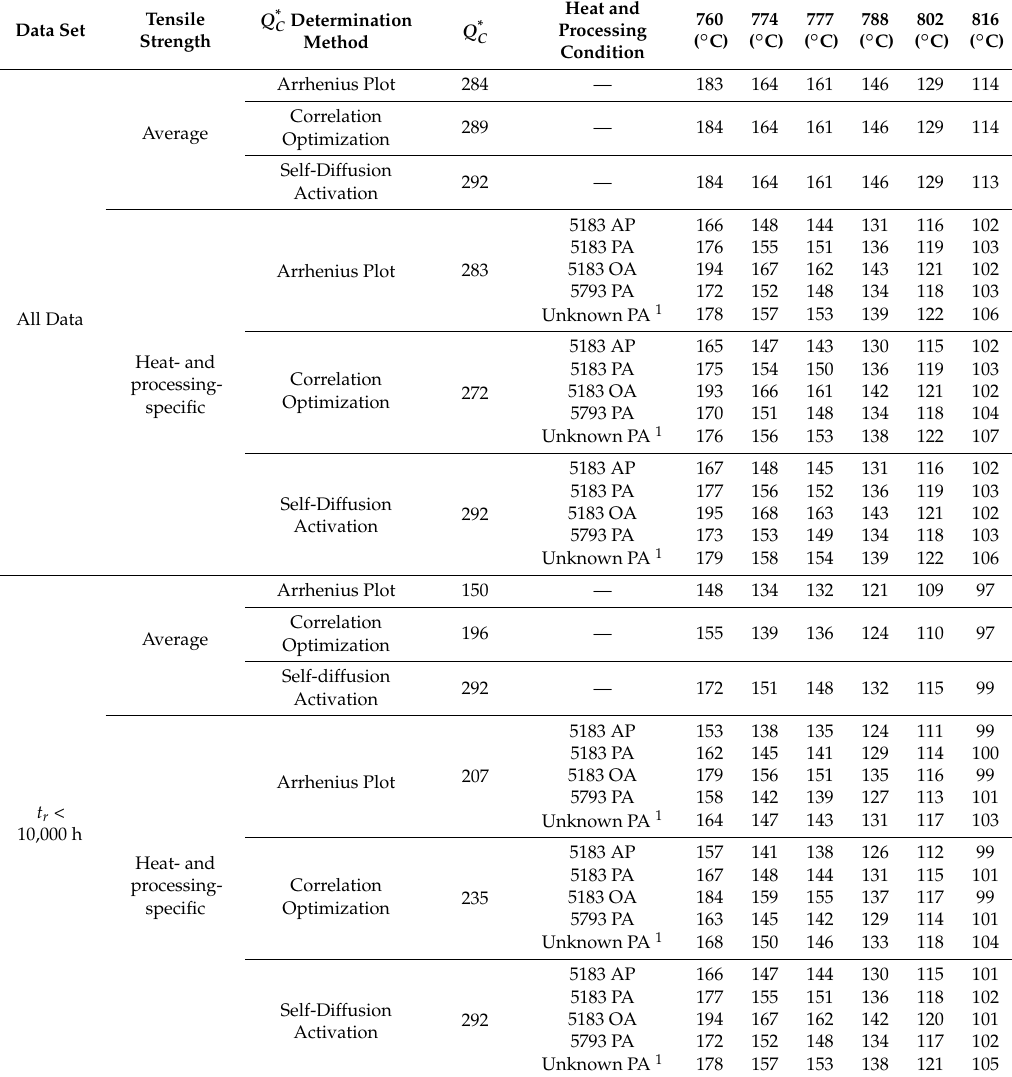
Table 8. Calculated creep strength for rupture of Nimonic 105 at 100,000 h (MPa). Data Set